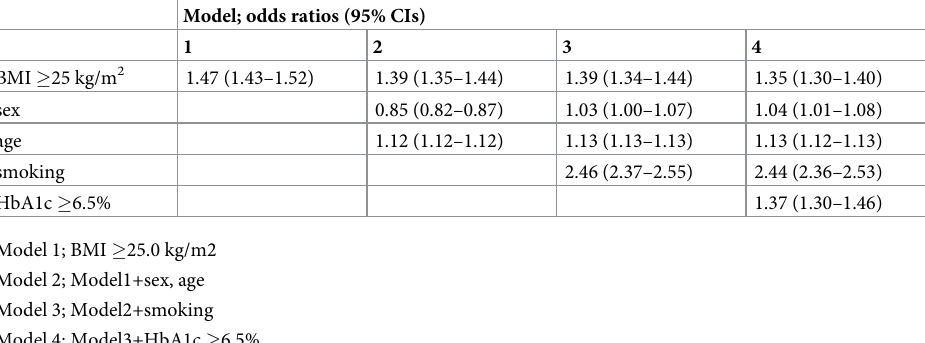
Table 2. The ORs for fewer than 24 residual